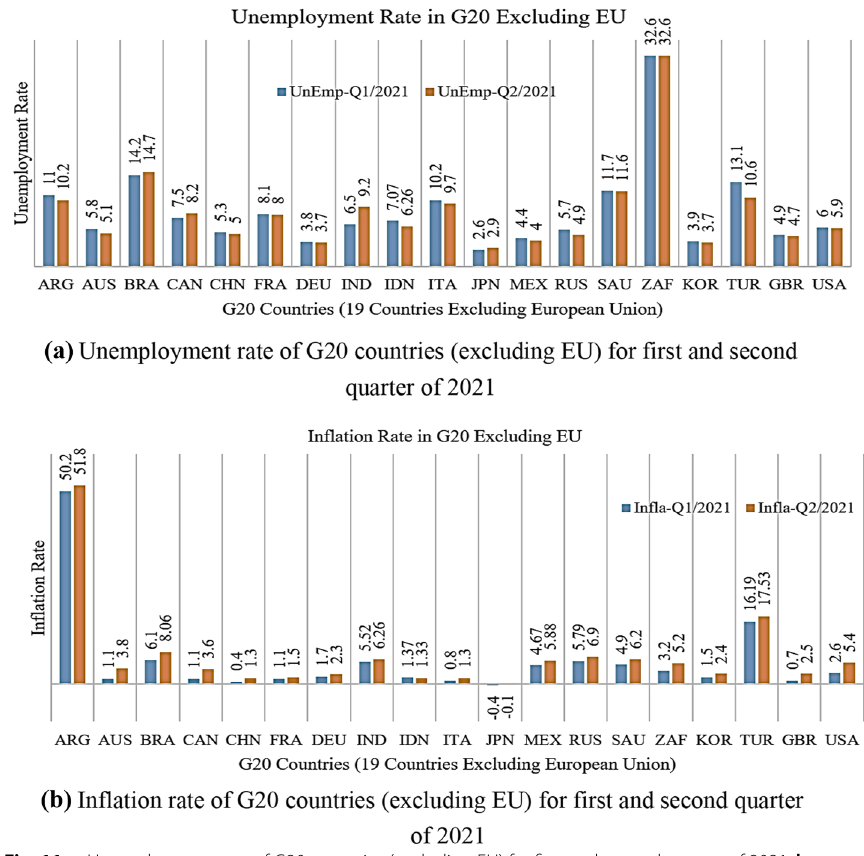
Fig. 11 a Unemployment rate of G20 countries (excluding EU) for first and second quarter of 2021. b Inflation rate of G20 countries (excluding EU) for first and second quarter of